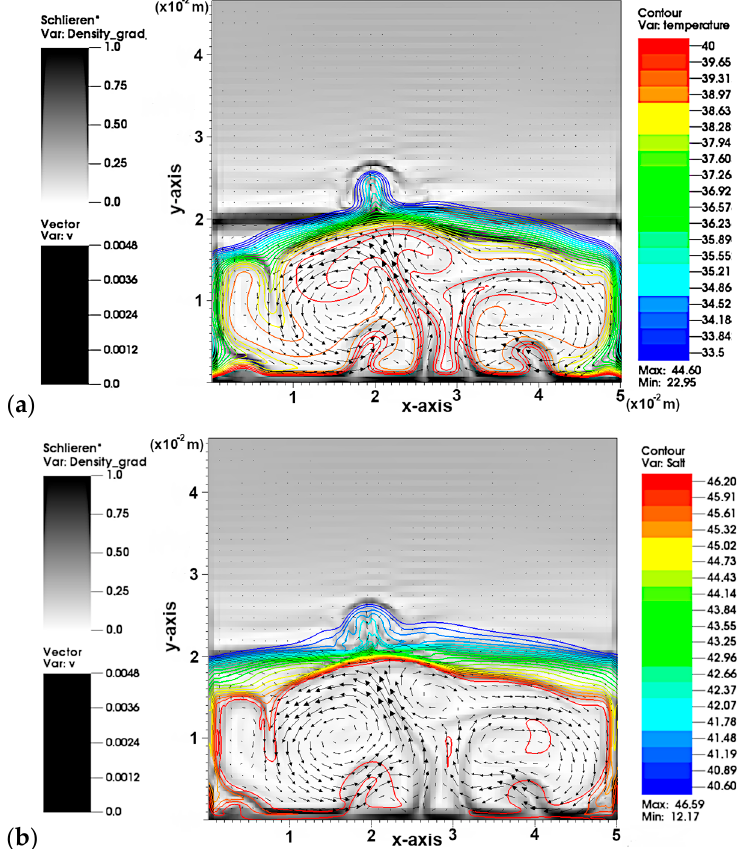
Figure 5. Schlieren image at t = 580 s overlayed with the predicted velocity field and ( a ) temperature contours or ( b ) salinity contours.